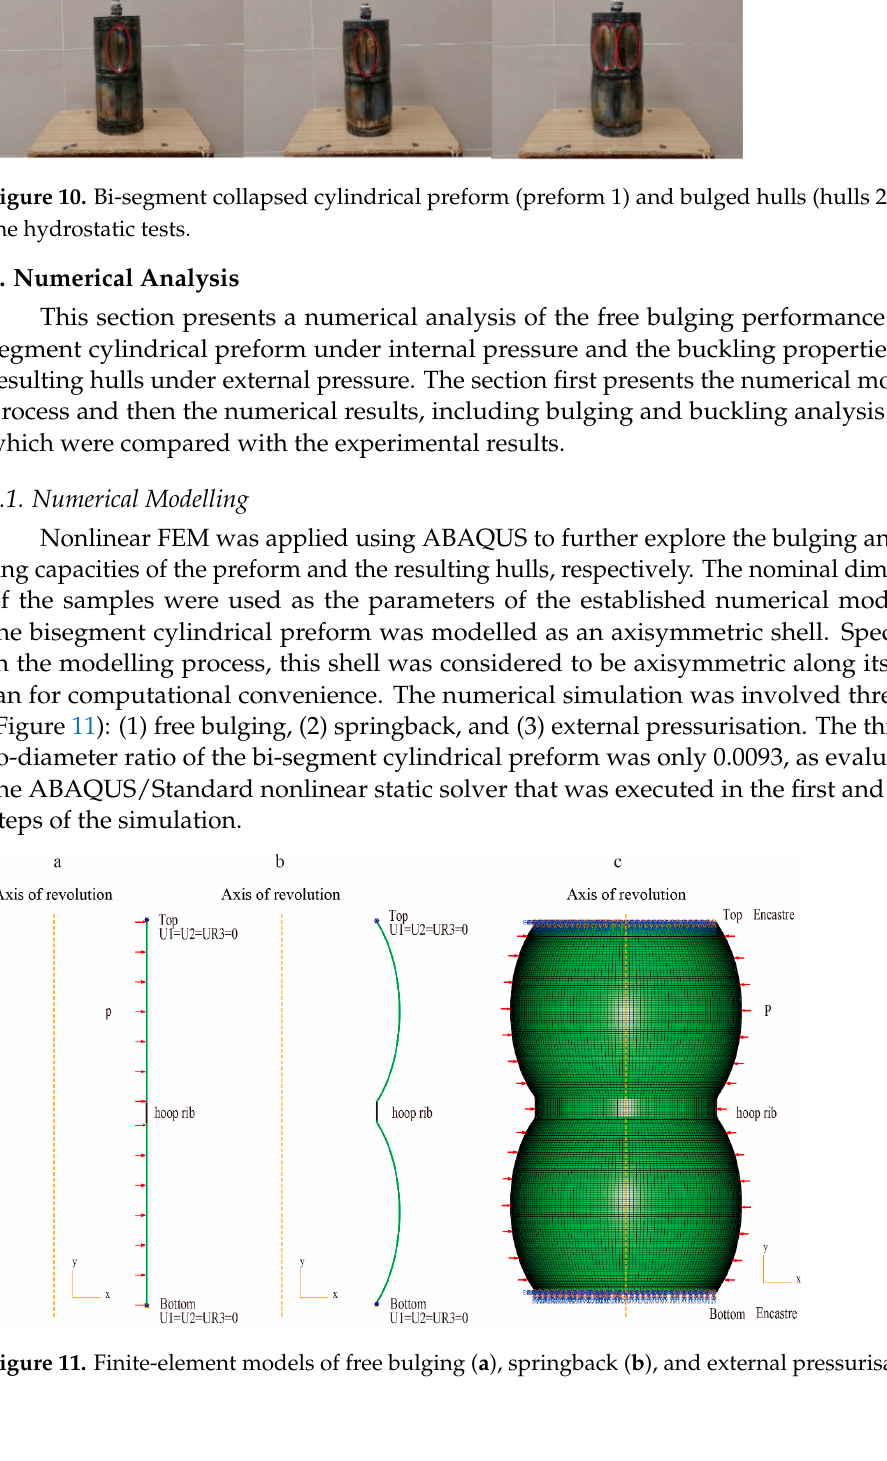
Figure 11. Finite-element models of free bulging ( a ), springback ( b ), and external pressurisation ( c ). From the axisymmetric shell element library of ABAQUS/Standard, two-node shell (SAX1) elements were used to establish the numerical model of the bi-segment cylindrical preform. A one-dimensional linear numerical model was divided into 213 axisymmetric nodes (Figure 11). To simulate the closed constraints of the two thick plates and the hoop rib on the numerical model, the top and bo tt om points of the model were completely fi xed, and the hoop rib nodes were given full degrees of freedom, which was the same as a previous study [31]. The maximum values for bulging magnitude ∆ B for the numerical model were set to 0, 1, 2, 3, 4, 5, and 6 mm. Figures 12–15 show the geometrical and mechanical properties observed for the bulged and springback models. The springback model (Figure 11b) was rotated to derive a 3D model (Figure 11c), and the geometrical and material properties of the derived model were assessed through nonlinear FEM. The fi nite element meshes in the 3D model were obtained by rotating 213 isometric deformed fi nite element meshes. Thus, the mesh and node numbers for the seven bi-segment pressure hulls were 42,600 and 42,400, respectively. The converted meshes were determined to be linear quadrilateral elements (S4R), and the number of meshes was veri fi ed by convergence, as shown in Figure 16. The thickness of each bi-